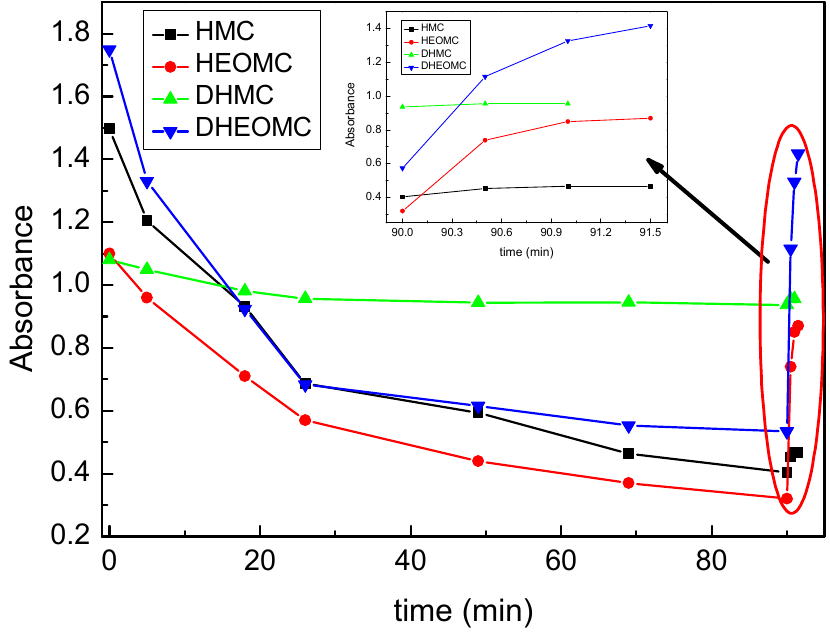
Figure 4. Photo-reversibility cycle of coumarin derivatives.